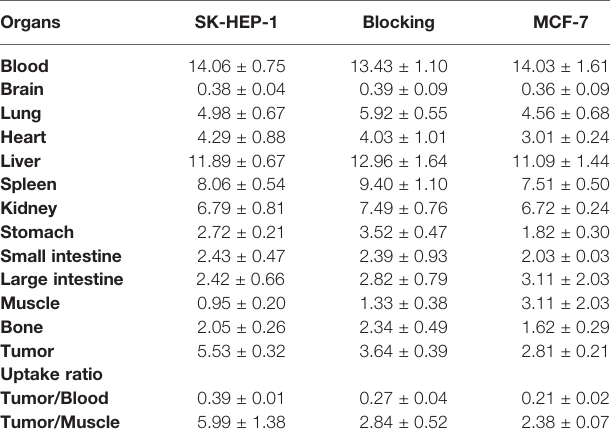
TABLE 1 | Biodistribution of 99m Tc-HYNIC-S1PR1mAb in SK-HEP-1 (including the SK-HEP-1 group and the blocking group) and MCF-7 tumor-bearing nude mice at 24 h